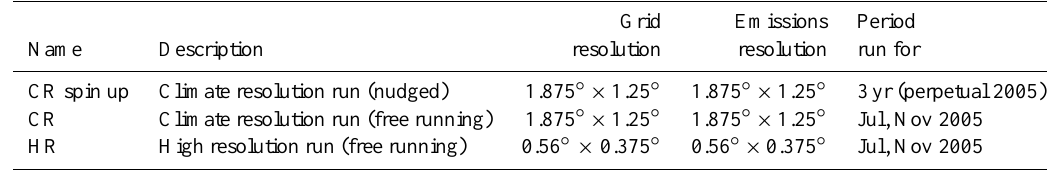
Table 1. A summary of the UM-UKCA runs performed.